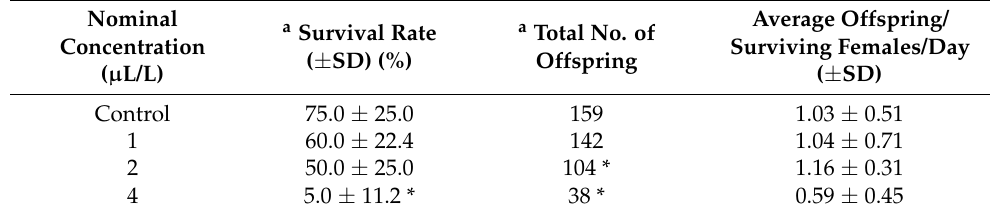
Figure 2. ( a ) Survival rate (%) and ( b ) cumulative number of M. macrocopa offspring. Table 5. M. macrocopa survival rate after exposure to different concentrations of benzyl chloride in stream mesocosms. Nominal concentration